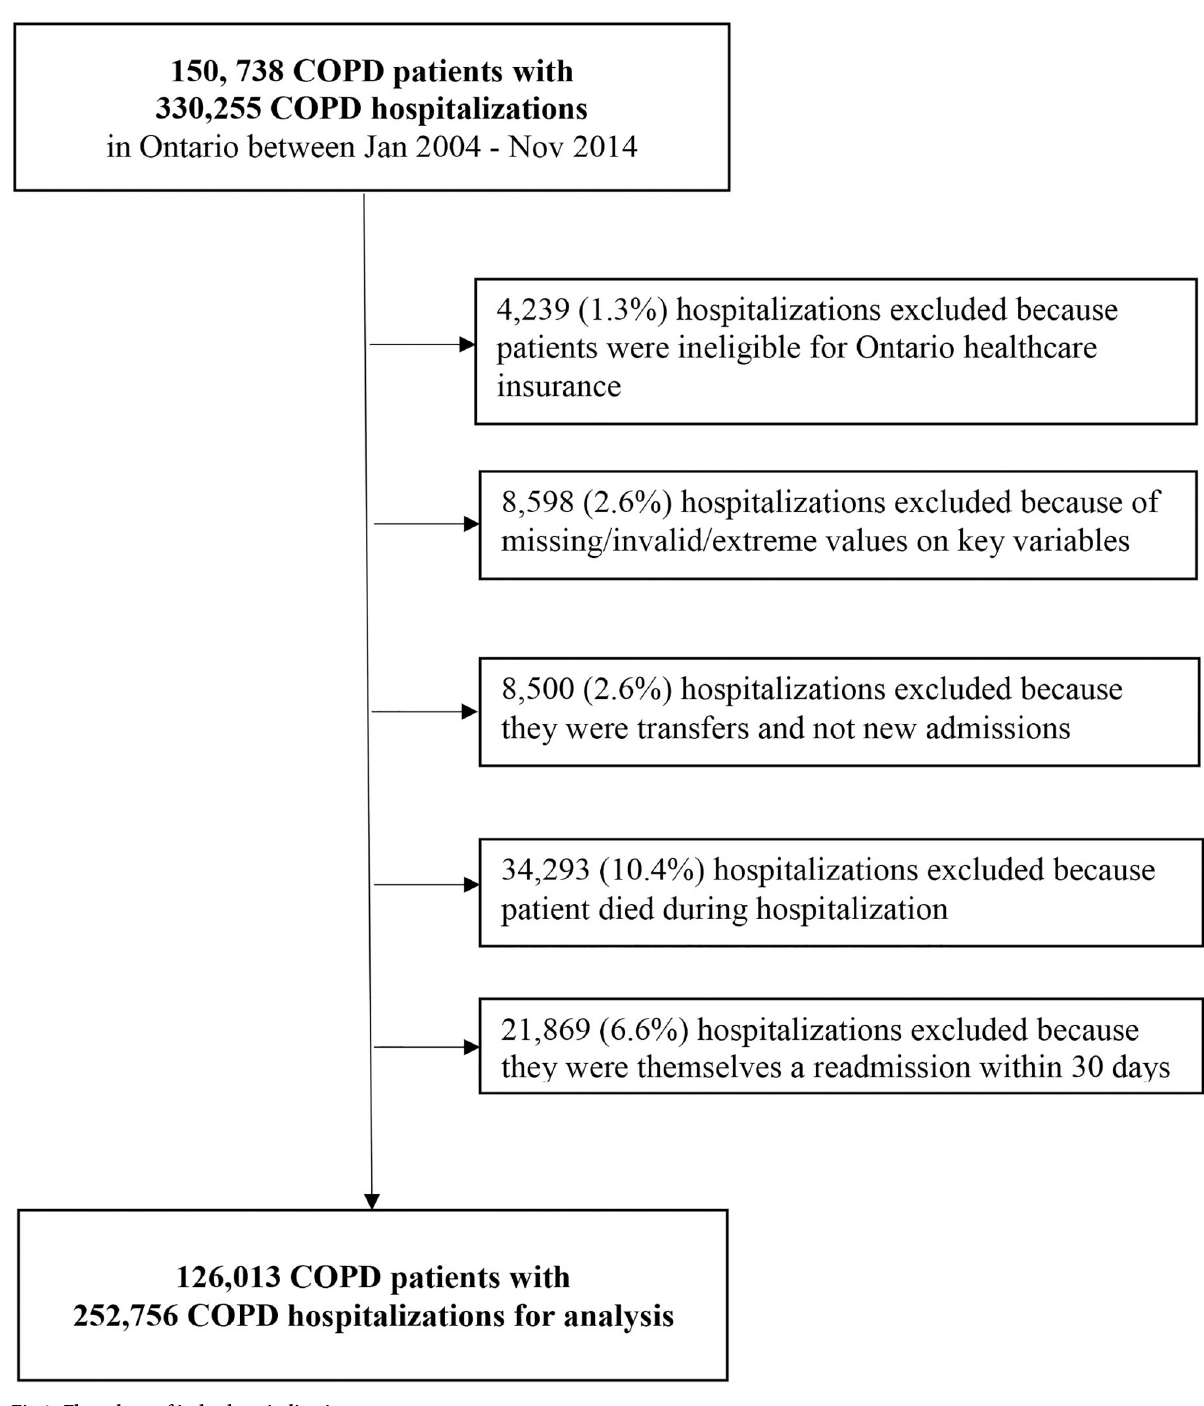
Fig 1. Flow chart of index